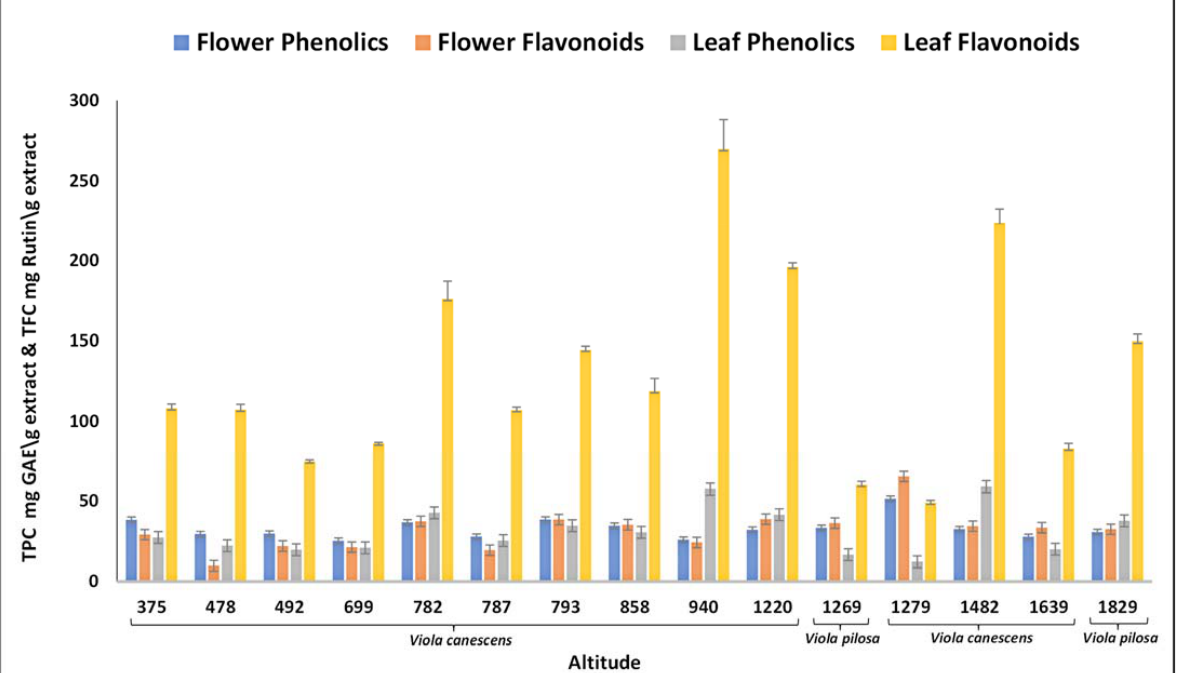
Figure 2. Total phenolic and total flavonoid contents accumulation in Viola species at gradient alti ‐ tudes. GAE—gallic acid equivalent.